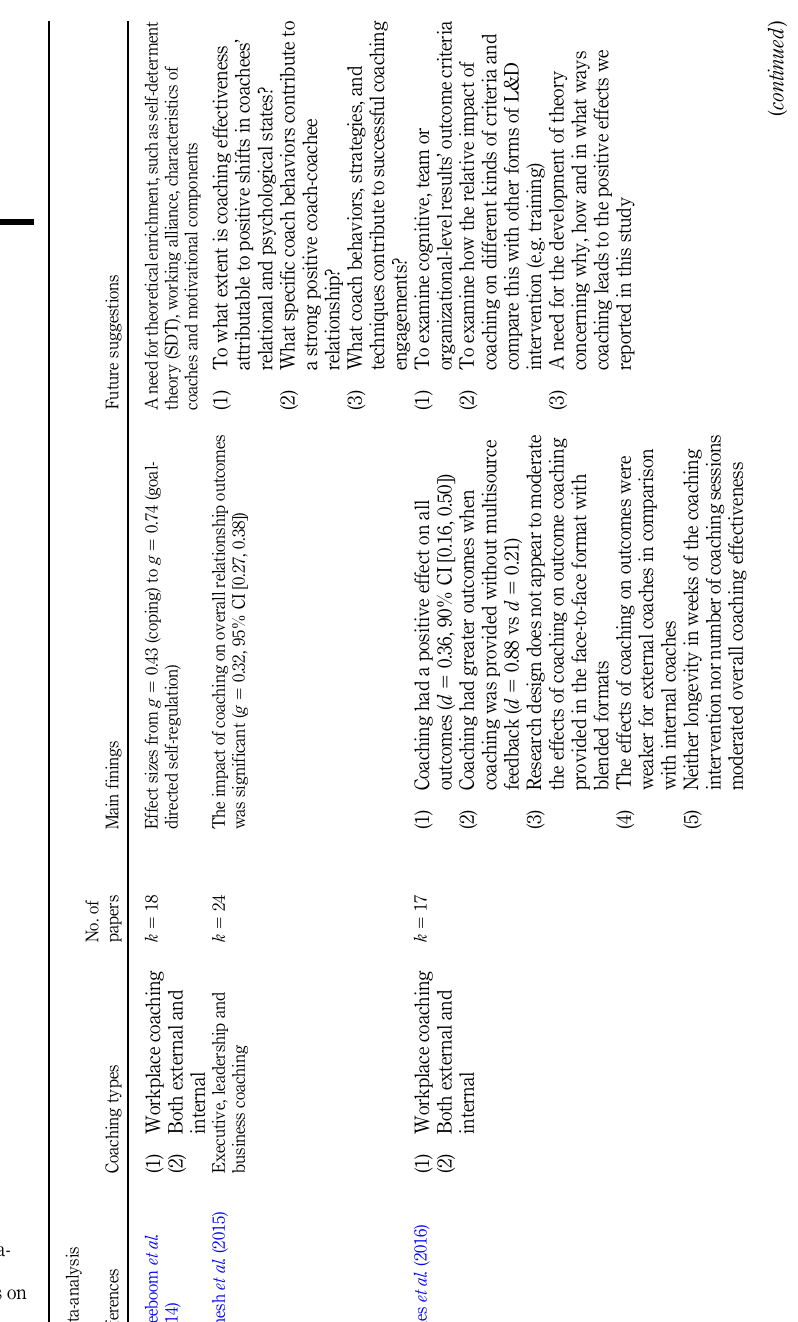
Table 1. A meta-review of contemporary meta- analyses and systematic reviews on